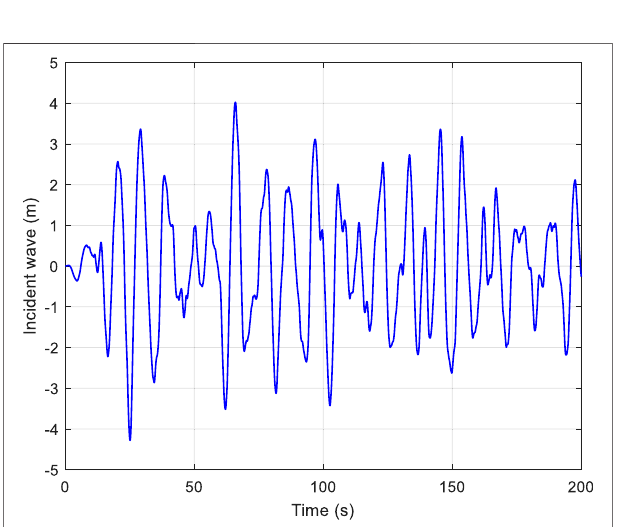
FIGURE 8 | Incident wave acting on the spar-type fl oating offshore wind turbine.